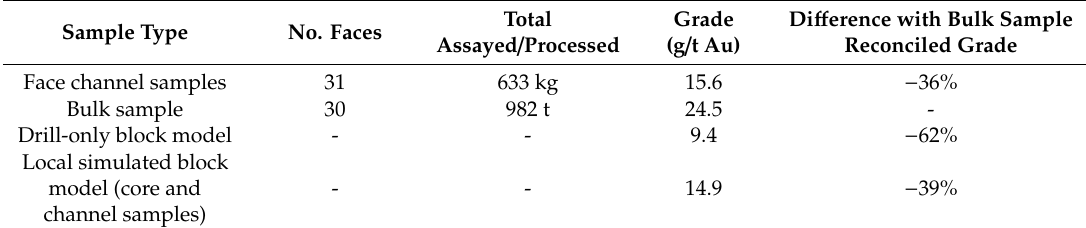
Table 25. Comparison between diamond drill, channel samples and bulk sample estimates for the Veta Christina South bulk samples with the plant head grade. All estimated grades account for intentional and unintentional dilution.